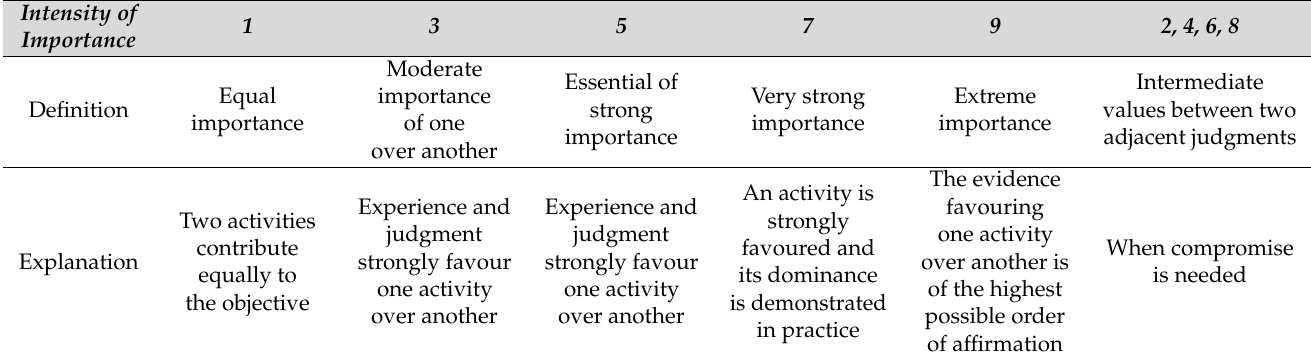
Table 2. Importance weighting according to Saaty